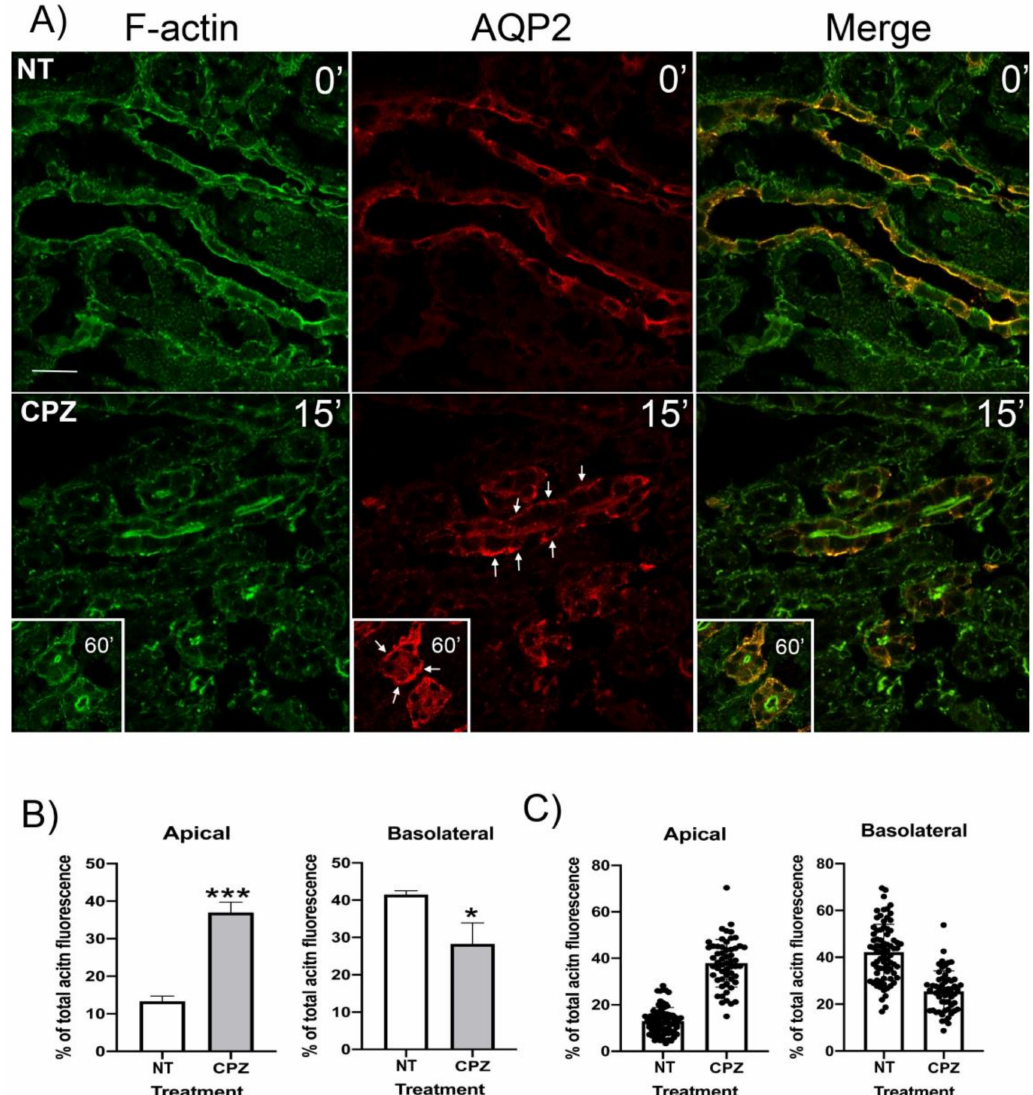
Figure 6. The e ff ect of chlorpromazine on F-actin in rat kidney slices: rat kidney slices were treated with and without CPZ 400 µ M 15 and 60 min ( A ) before fixation and immunostaining with anti-AQP2 antibody (red). F-actin was labeled with FITC-conjugated phalloidin (green). The basal condition (NT) showed apical or cytoplasmic distribution of AQP2 and F-actin in principal cells from the outer medulla. F-actin was also observed in the basolateral membrane. In contrast, CPZ treatment at both 15 and 60 min resulted in basolateral accumulation of AQP2 (arrows). F-actin appears more abundant in the apical pole than the basolateral pole in outer medullary principal cells. A comparison of F-actin distribution between the untreated condition and the 60 min CPZ treatment (inserts) shows a marked modification of F-actin distribution that favors apical membrane localization over basolateral localization (see quantification in B and C ). The images are representative of three independent experiments (bar = 10 µ m for all panels). Fluorescence intensity of F-actin at the apical and basolateral membranes was analyzed and expressed as the % of the total F-actin fluorescence in the cell (panels B and C ). More than 20 cells were analyzed in 3 di ff erent animals and results were expressed as an average of each experiment (panel B ; means ± SD, n = 3). They were analyzed using the Student t test (*** p < 0.001 and * p < 0.05). In panel C , all of the individual measurements from the three stained tissues are illustrated together to show the spread in values among the conditions